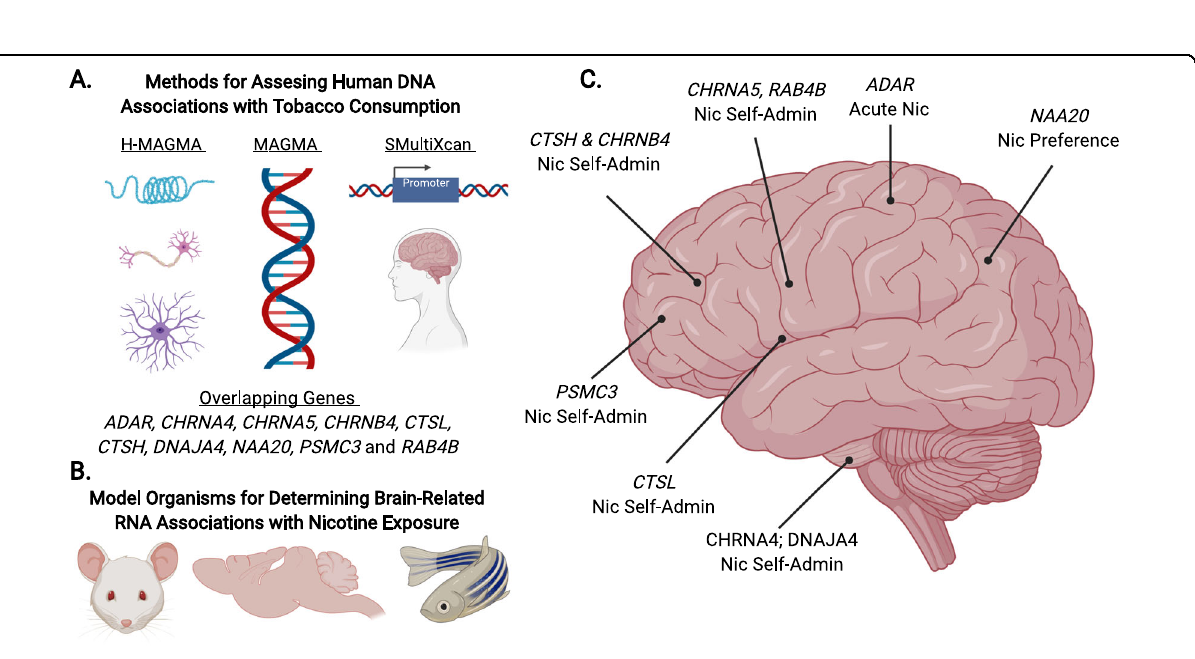
Fig. 3 Potential functions of genes associated with nicotine consumption. This fi gure shows a schematic representation for interpreting our cross-species genetic associations with A Human tobacco consumption, B Model organism nicotine exposure and inferring their effects in the C Human brain. Note: Nic means nicotine; Self-Admin refers to